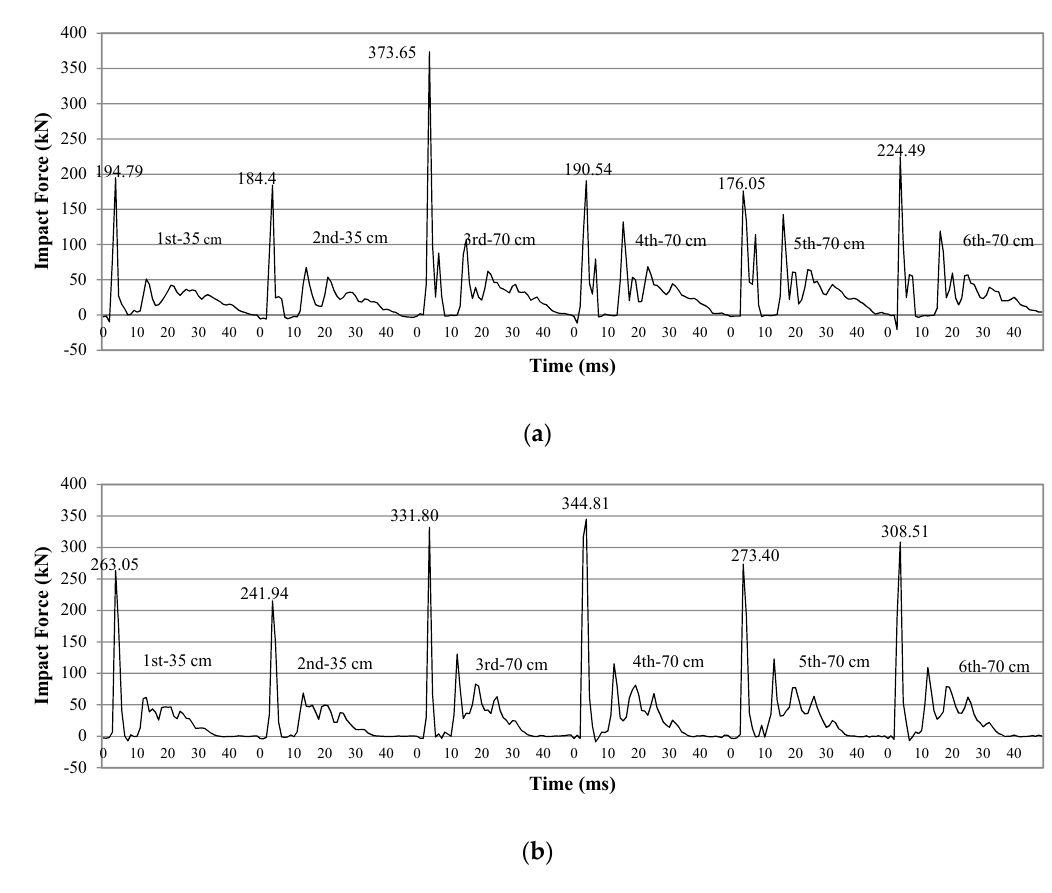
Figure 4. Impact load time history: ( a ) specimen I00-1 and ( b ) specimen I28-2.